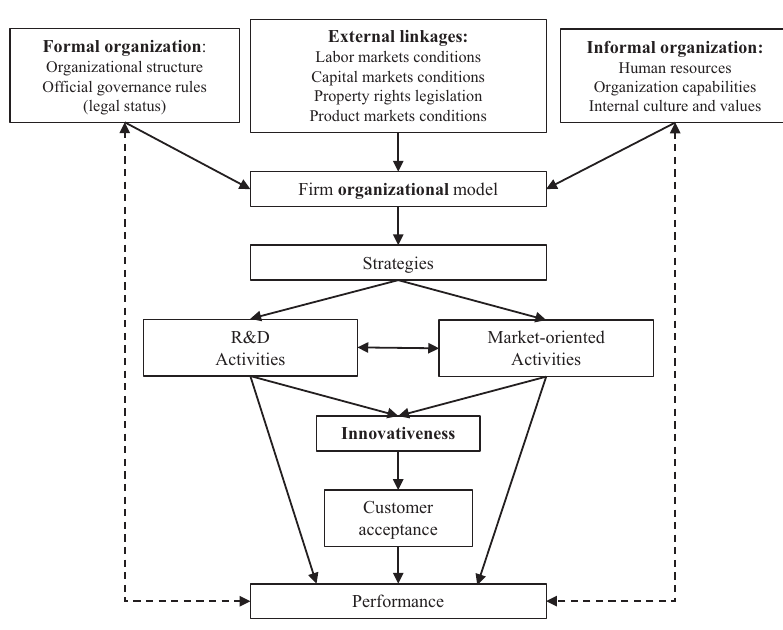
Figure 1. Innovativeness explanatory model in the food sector